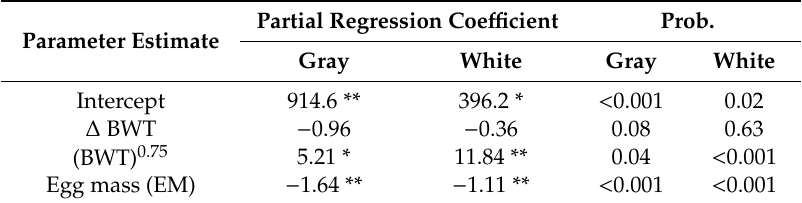
Table 5. Partial regression coe ffi cients for factors a ff ecting expected feed intake of two varieties of Japanese